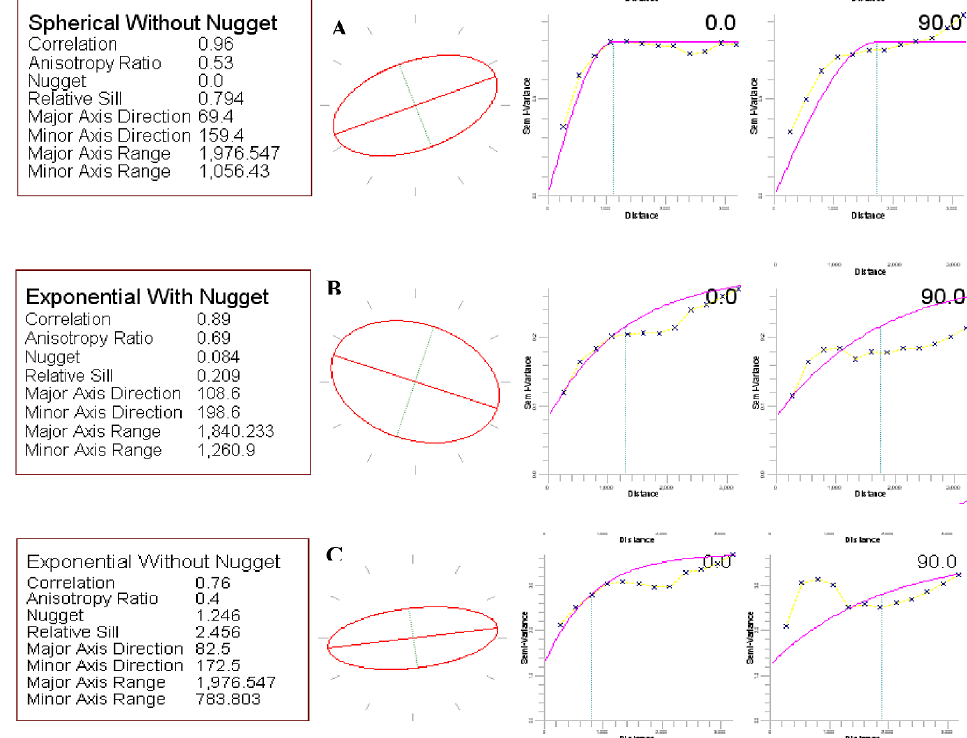
Figure 6. Variograms and anisotropic ellipsoids of the parameters: (a) frequency; (b) amplification; (c) K - g